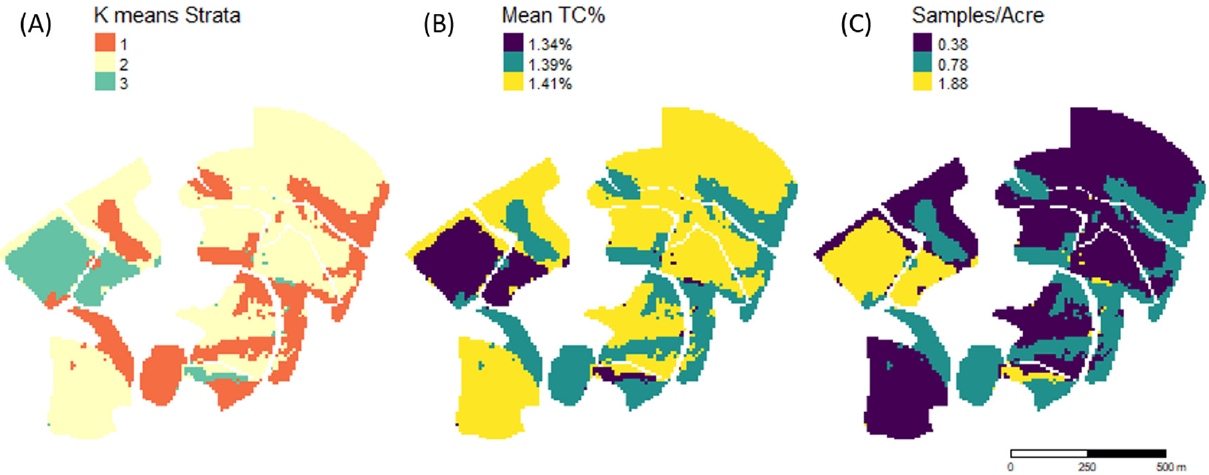
Figure 7. Strati fi cation with certain geospatial surfaces can lead to skewed sampling with certain in- strata sampling techniques. ( A ) Strata for CFF using Open Geospatial; ( B ) mean carbon values (from laboratory data) per strata; and ( C ) number of samples per acre with Even sampling with 100 samples across study